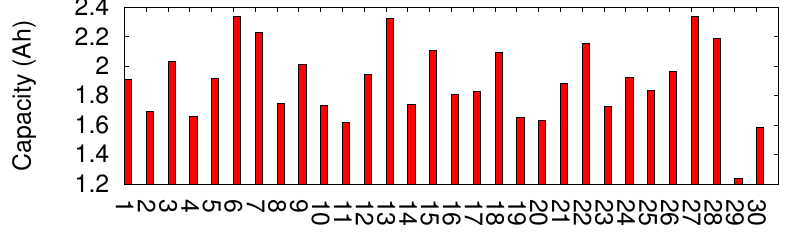
Figure 2. Aging-induced capacity degradation of 30 PHEV battery modules.